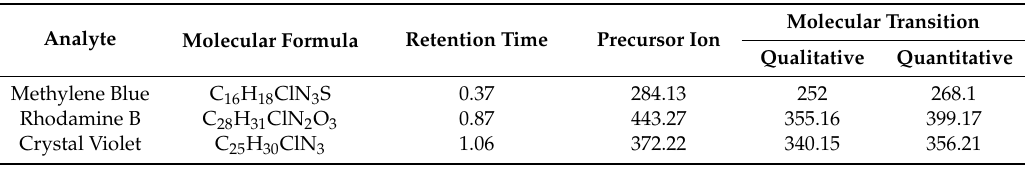
Table 2. Molecular formula, retention time and MRM parameters used for the determination of methylene blue, rhodamine B and crystal violet.